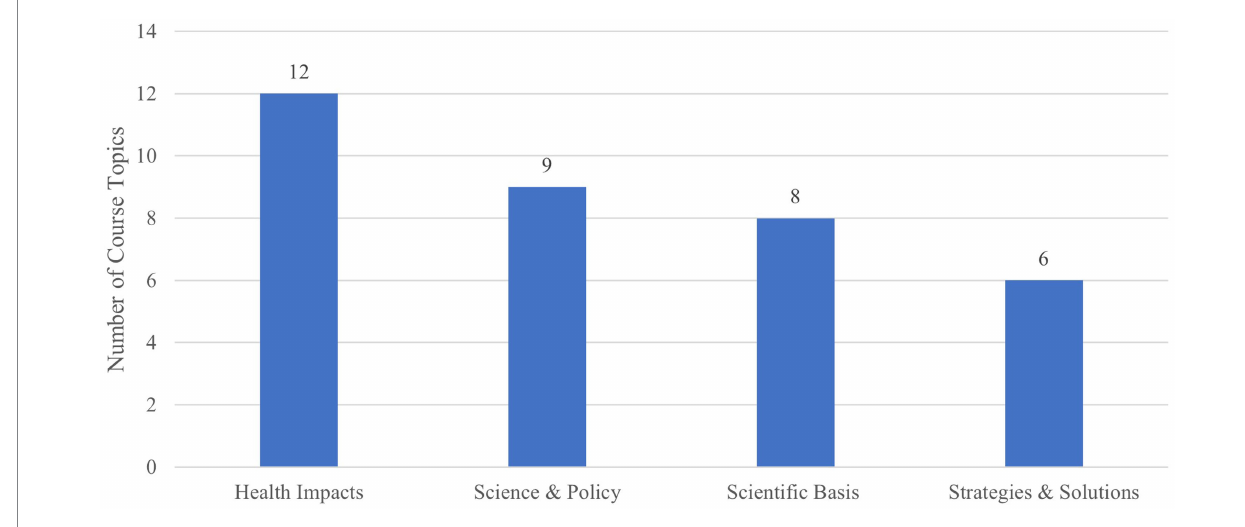
FIGURE 1 Most commonly taught topics in climate-health courses.